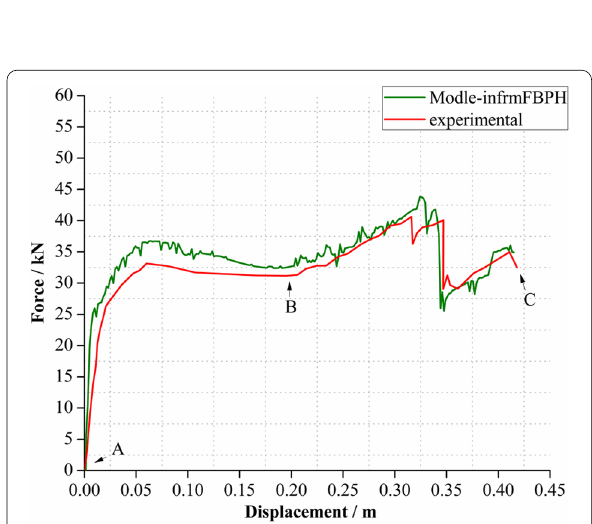
Fig. 3 Force–displacement curves of the experimental (Li et al., 2016) and numerical models of the frames.